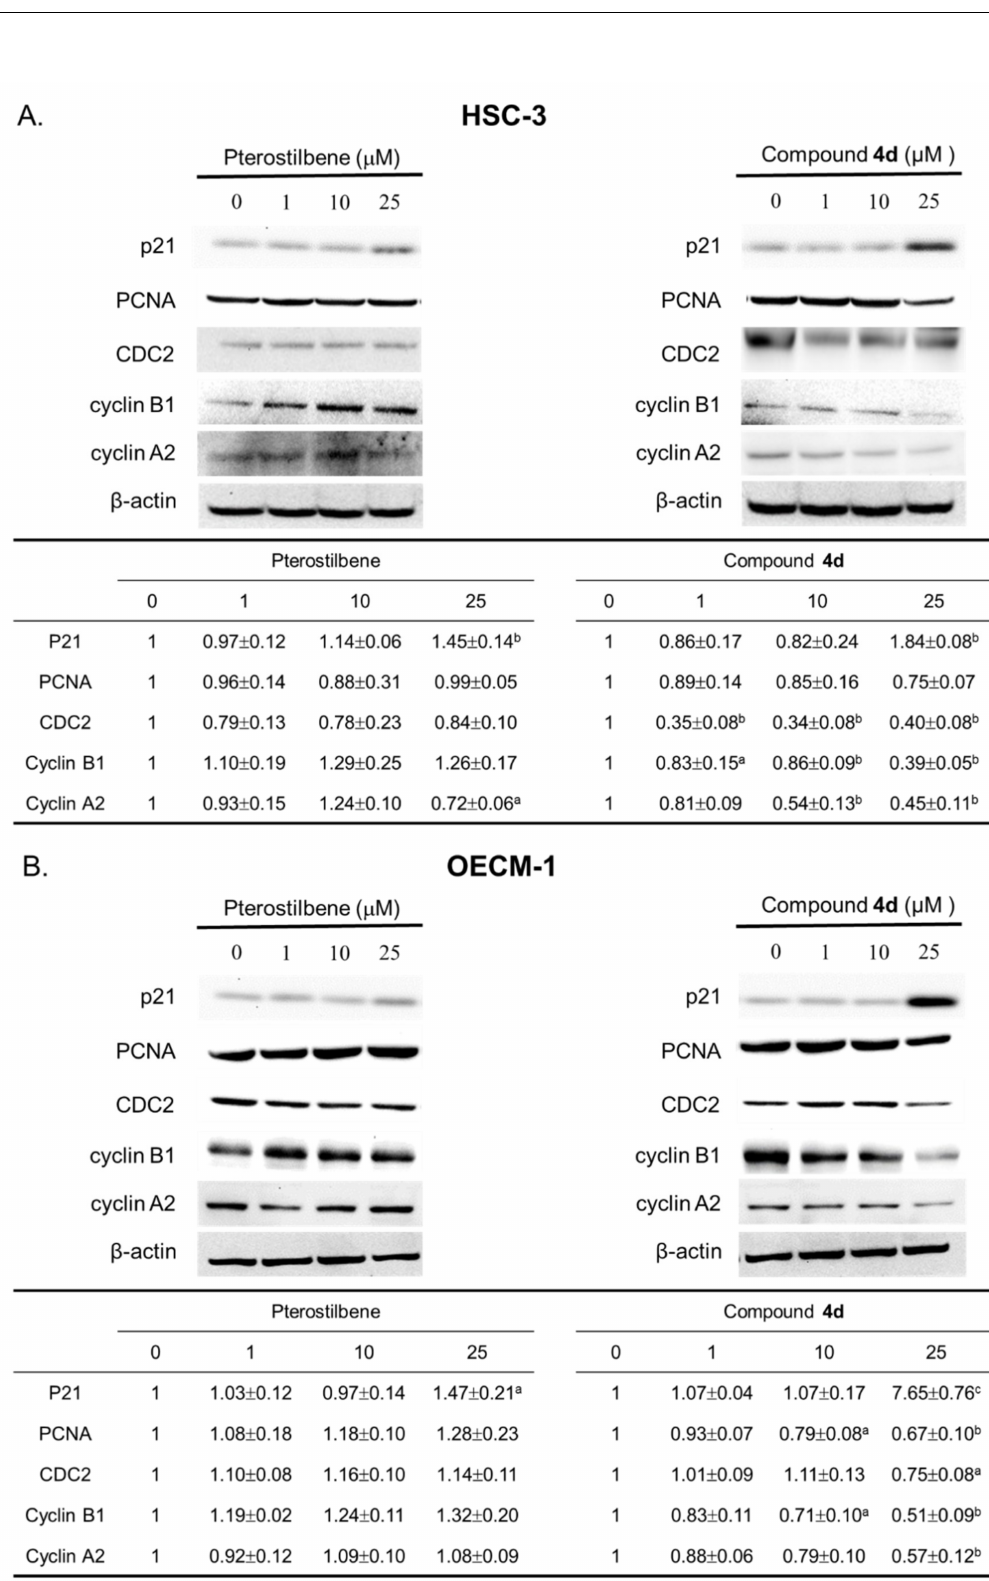
Figure 5. G2/M phase arrest induced by compound 4d through modulation of cell cycle regulators. For protein expression analysis of cell cycle regulators, ( A ) HSC-3, and ( B ) OECM-1 cells were treated by compound 4d or pterostilbene with 0 (DMSO control), 1, 10, and 25 µ M. 24 h later, the cells were harvested, lysed, and the protein was isolated. Protein expression of p21, PCNA, cdc2, cyclin B1, cyclin A2, and β -actin was evaluated by Western blot using corresponding antibodies. The data were quantitative and indicated as follows: a p < 0.05; b p < 0.01; c p < 0.001 between each group and vehicle